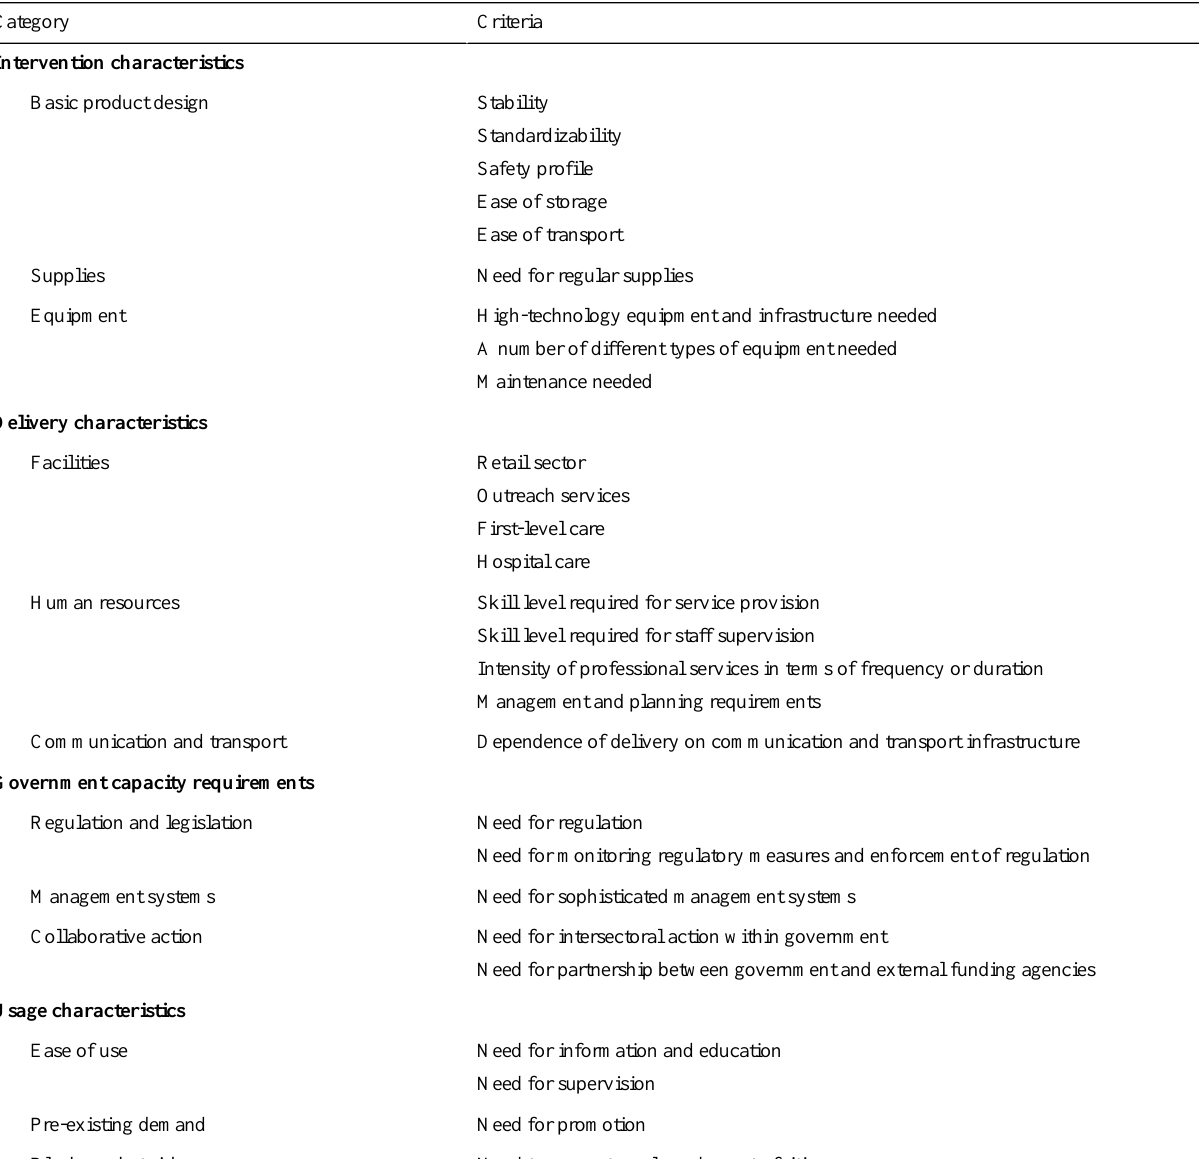
Table 1. Gericke et al’s framework to assess the technical complexity of health interventions [27].